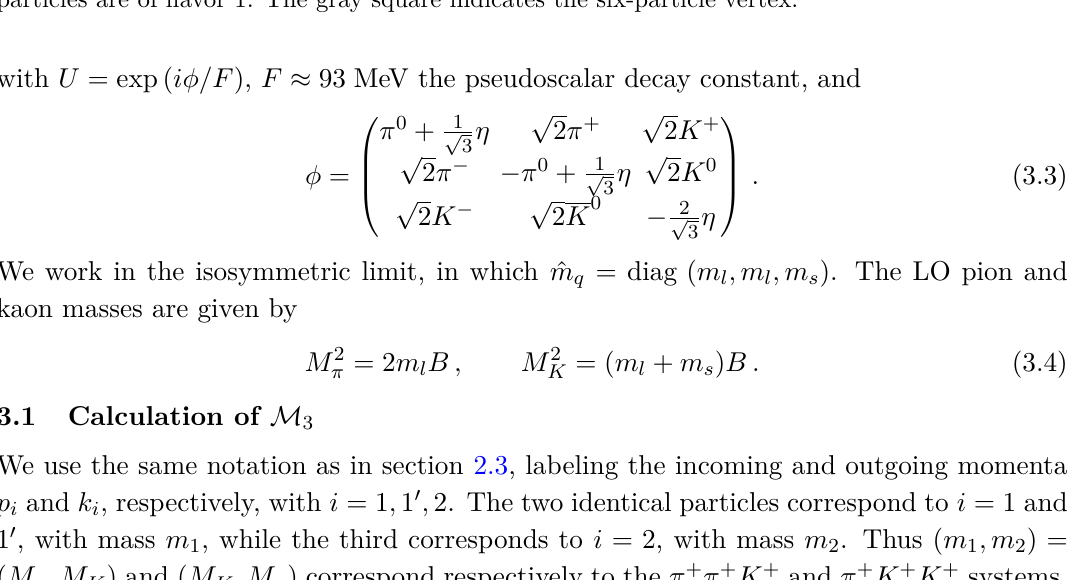
. Thin (thick) lines indicate particles of flavor 1 (2). Figure 2. Diagrams contributing to M LO 3 Four-particle vertices are denoted by circles: black if the particles are of different flavors, grey if all particles are of flavor 1. The gray square indicates the six-particle